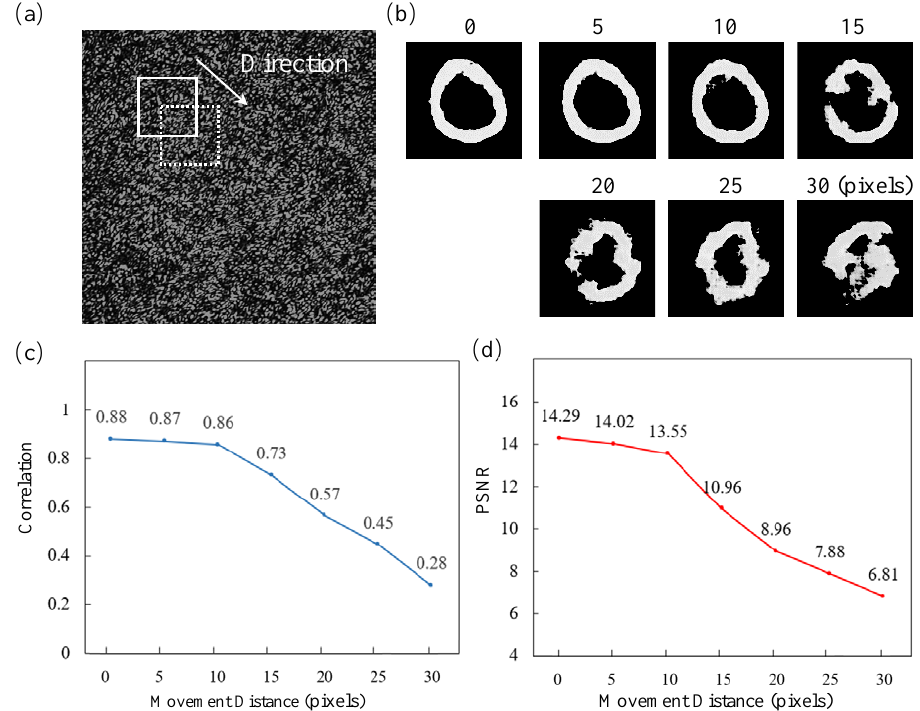
Figure 9. The generalization performance of scattering-assisted computational imaging method. ( a ) the sketch map of changing the remaining view; ( b ) the reconstruction results using a single well-trained network model; quantitative analyses of image quality on ( c ) correlation and ( d )